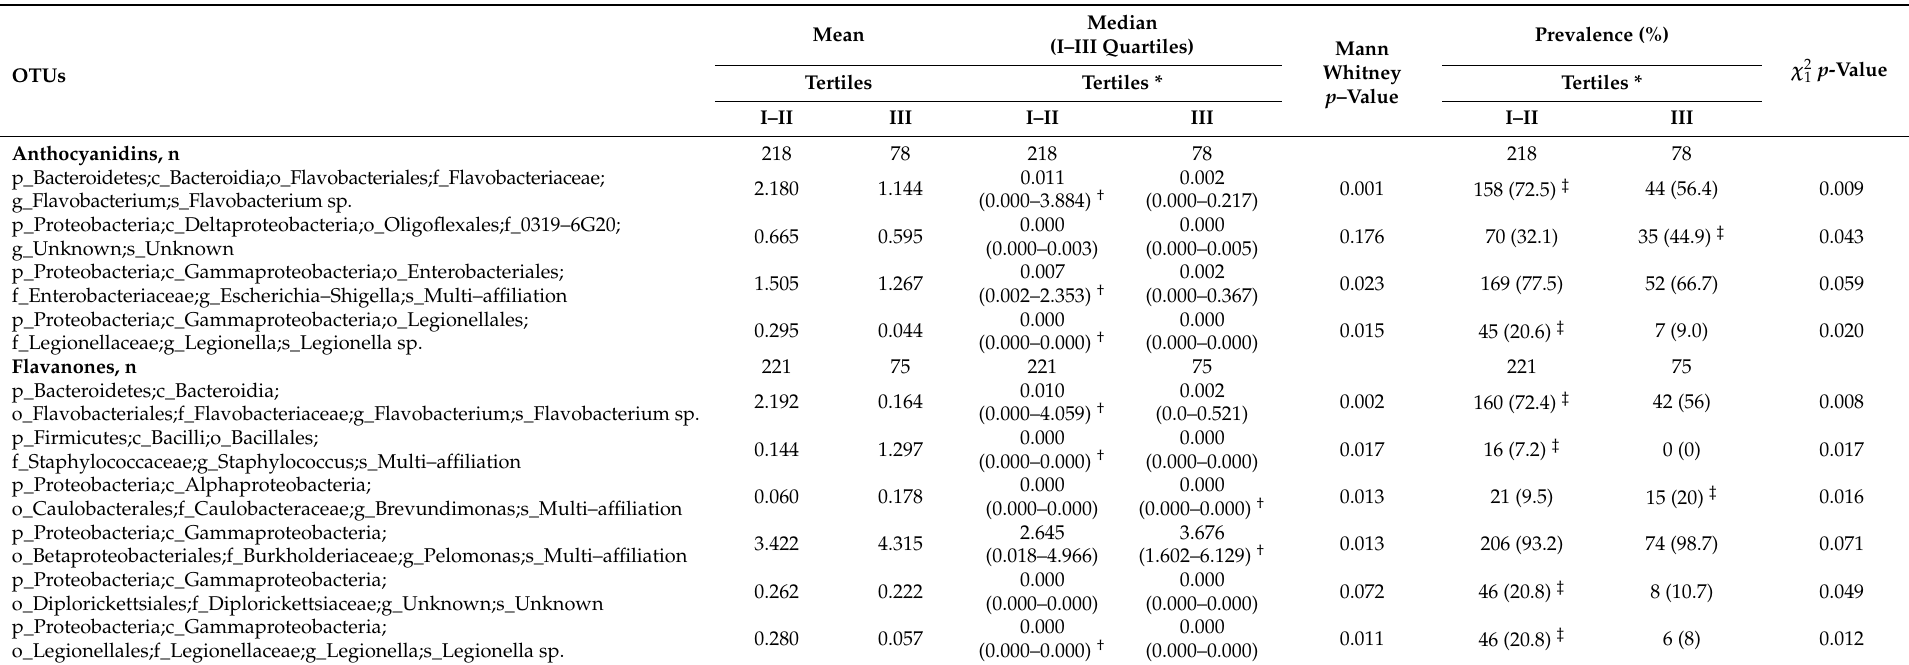
Table 5. Distributions of relative abundance and prevalence of selected operational taxonomic units (OTUs) in blood according to anthocyanidin and flavanone intake. Italy